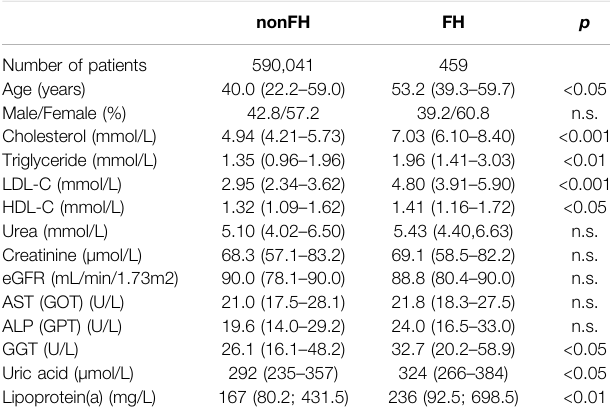
TABLE 1 | Clinical and laboratory data of the study populations. Data are presented as median (lower-upper quartile). nonFH